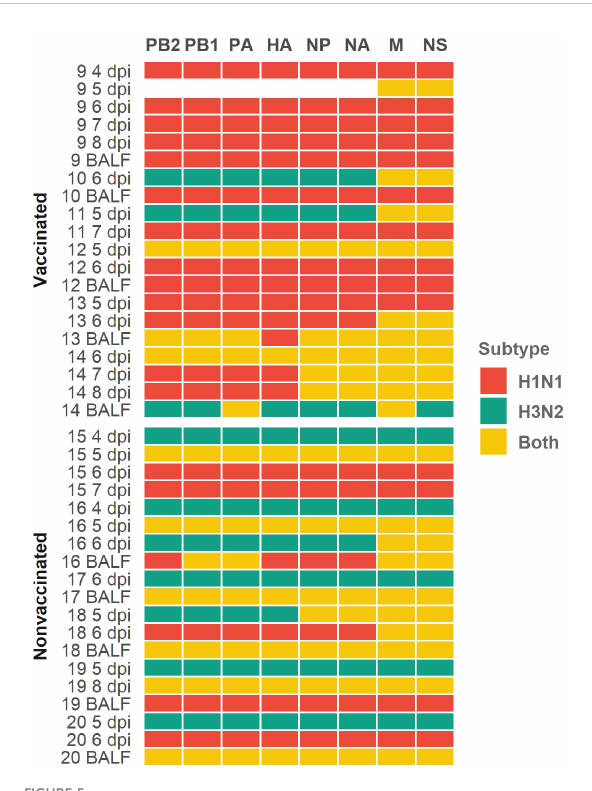
FIGURE 5 Pro fi le subtype identi fi cation per genomic segment in each sequenced sample heatmap. H1N1 subtype segments are indicated in red cells, H3N2 ones are indicated in green cells and yellow ones indicate that both subtypes were simultaneously found. Genomic segments and samples collected from vaccinated and nonvaccinated animals are represented on the x and y axes respectively. The number of each sequenced sample indicate the animal from which each sample was collected. Sample collection day are also indicated as dpi in nasal swab samples; BALF samples were collected on the day of